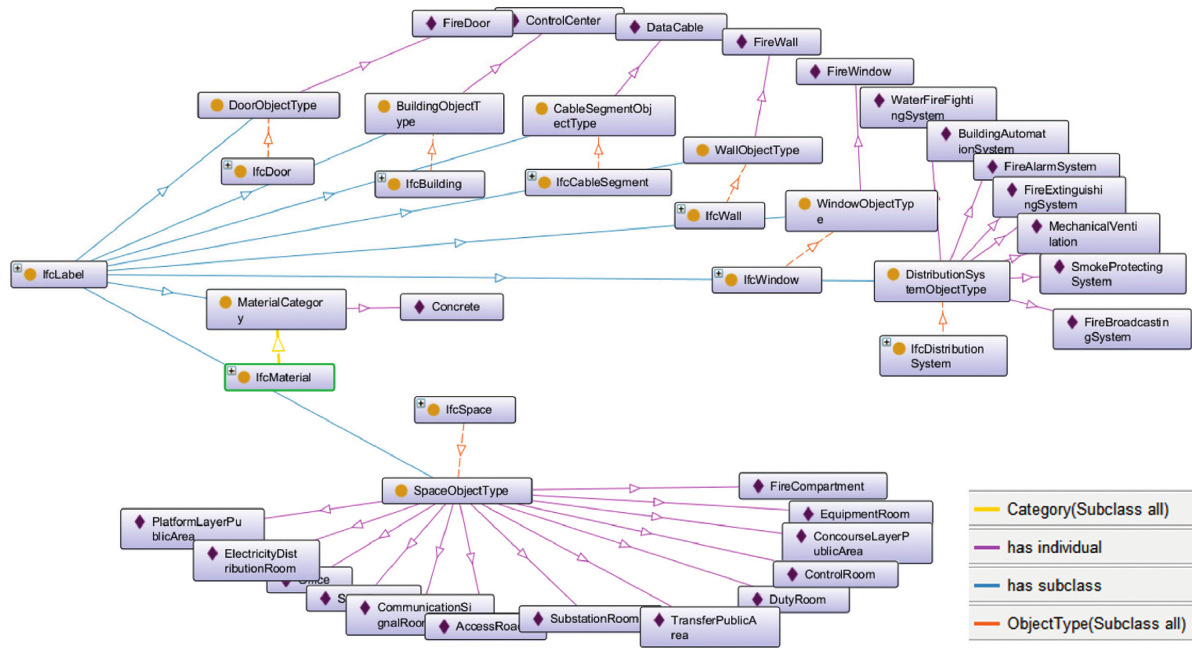
Figure 11: The extended attribute value in